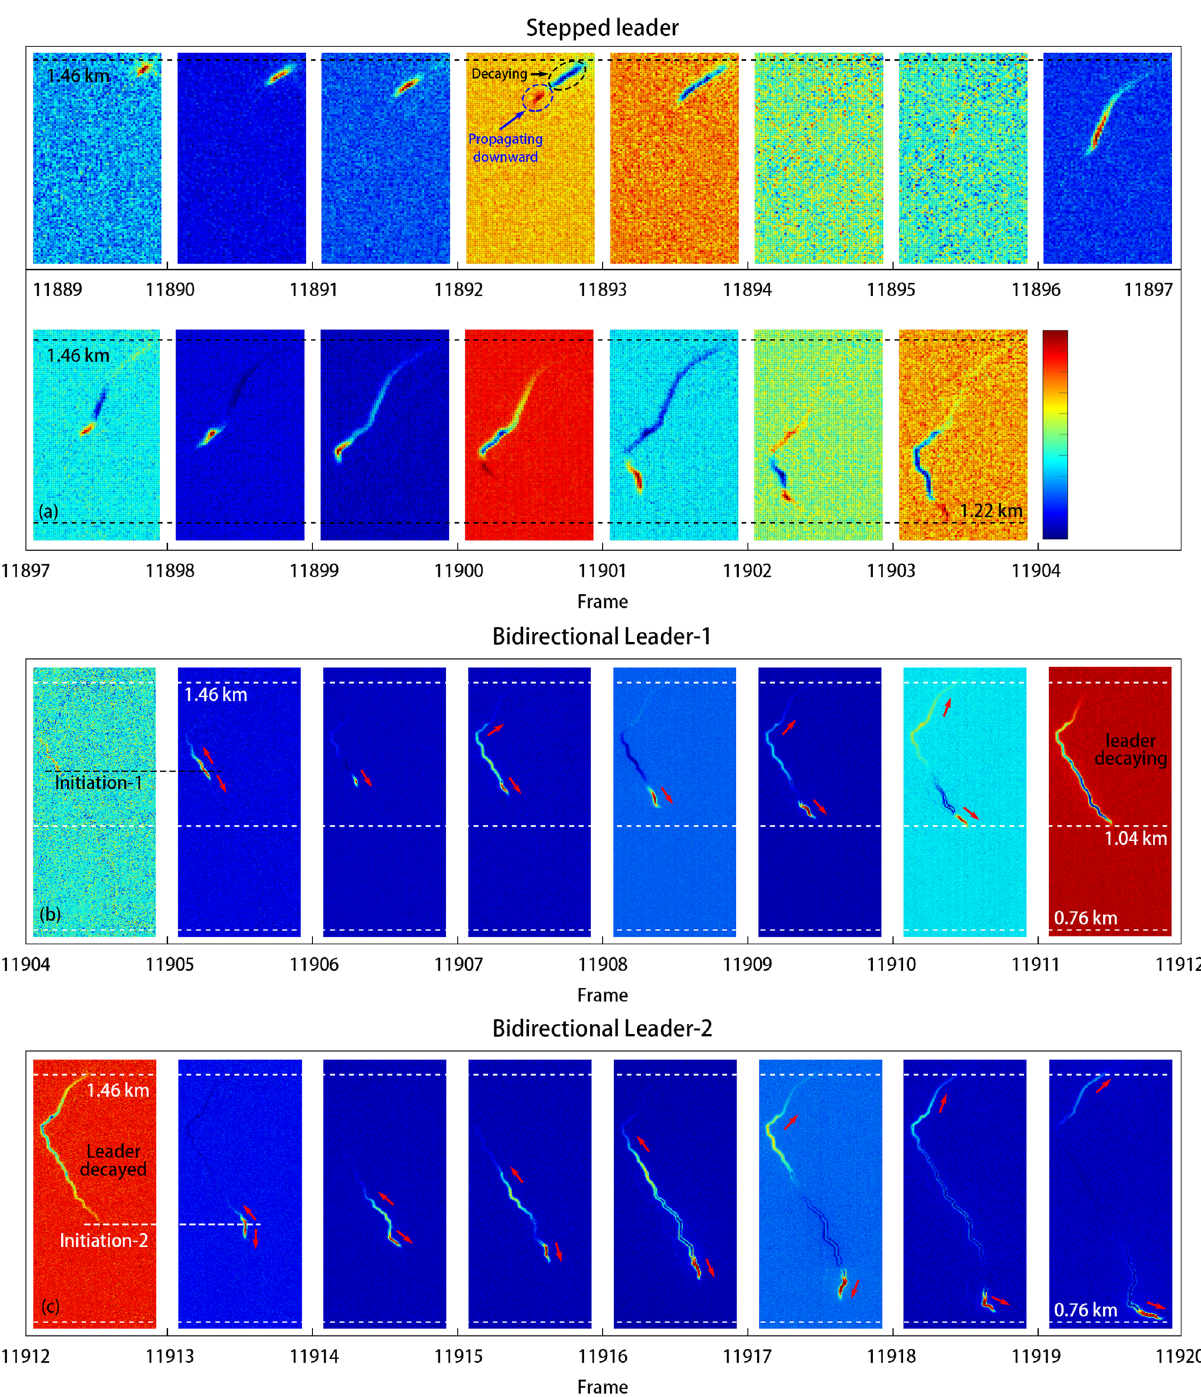
Figure 4. Digital differential pixel-array between two cropped consecutive frames of the stepped leader and the bidirectional leader processes. Use the light intensity of each pixel in the latter frame to minus the intensity value of the corresponding pixel in the former frame, getting the difference